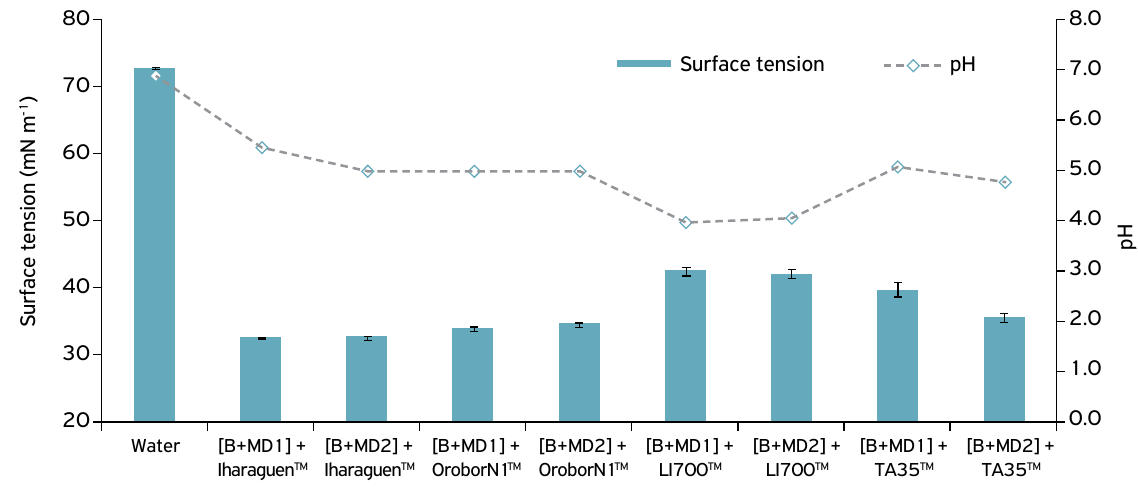
Figure 2. Static surface tension (confidence interval between means ± IC 95%) and pHs of the in tank mixtures of bispyribac-sodium